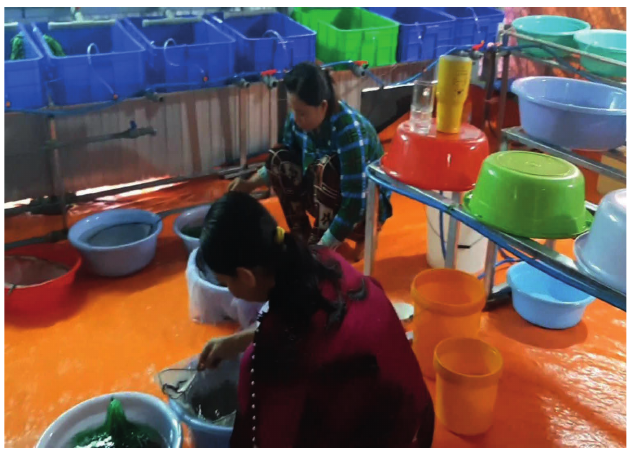
Fig. 1. An illustration of workers counting breeding eels manually at an eel farm in Mekong delta,